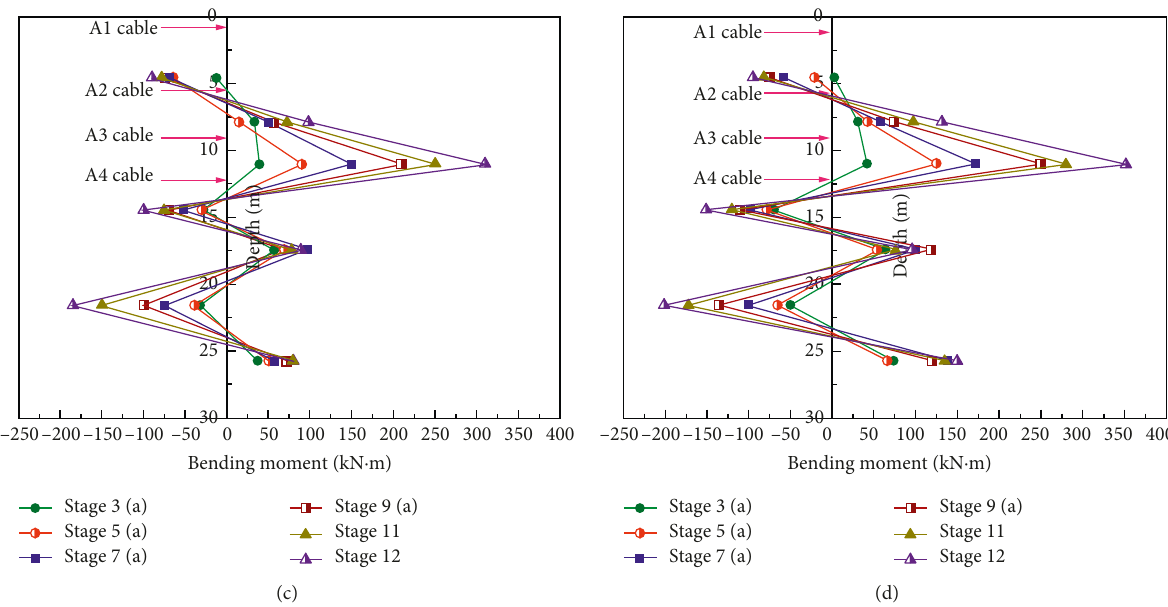
Figure 17: The bending moment of diaphragm wall. (a) The east segment. (b) The north segment. (c) The west segment. (d) The south